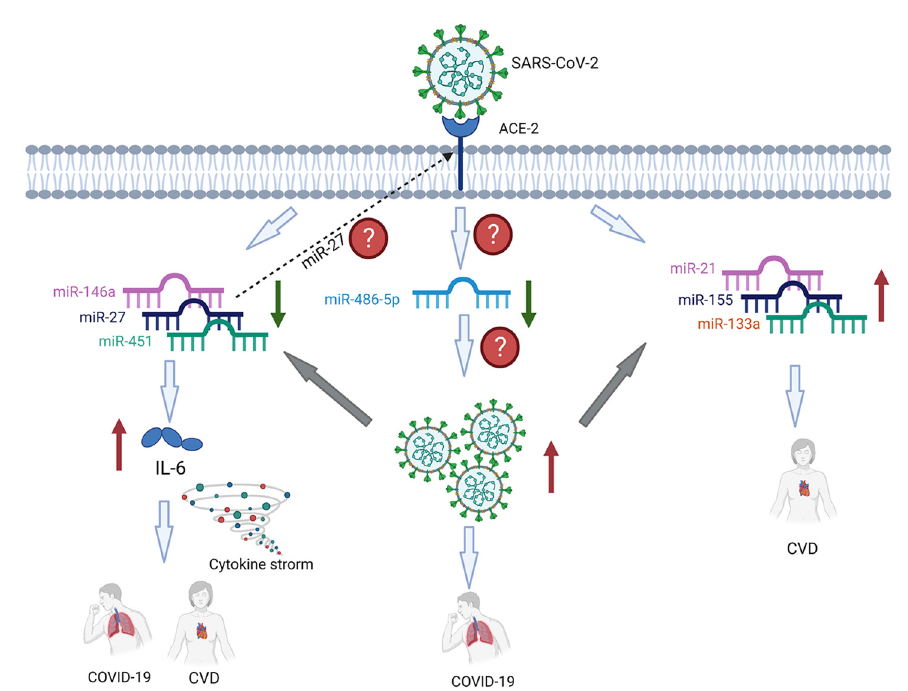
Figure 1. Potential associations between alterations of miRNA levels after infection with SARs-CoV-2 virus and the development of CVDs. Viral infection causes downregulation of miR-146a, miR-27, and miR-451, which are well-established inhibitors of IL-6 protein and IL-6 mRNAs, leading to the overproduction of several pro-inflammatory cytokines, a process known as cytokine storm. This phenomenon has been implicated in the pathogenesis of coronaviruses disease-19 (COVID-19) and cardiovascular diseases (CVDs). Expression levels of miR-27 could also correlate with the expression of the ACE-2 receptor, which provides the entry point of SARS-CoV-2. On the other hand, SARS-CoV-2 infection causes the upregulation of miR-21, miR-155, and miR-133a which are implicated in the development of CVD. A SARS-CoV-2 infection causes downregulation of miR-486-5p, facilitating the replication of the virus by weakening the immune system response. Question marks (?) represent factors that should be examined